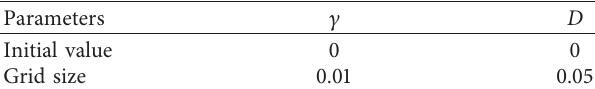
Table 6: Parameter setting of grid searching.